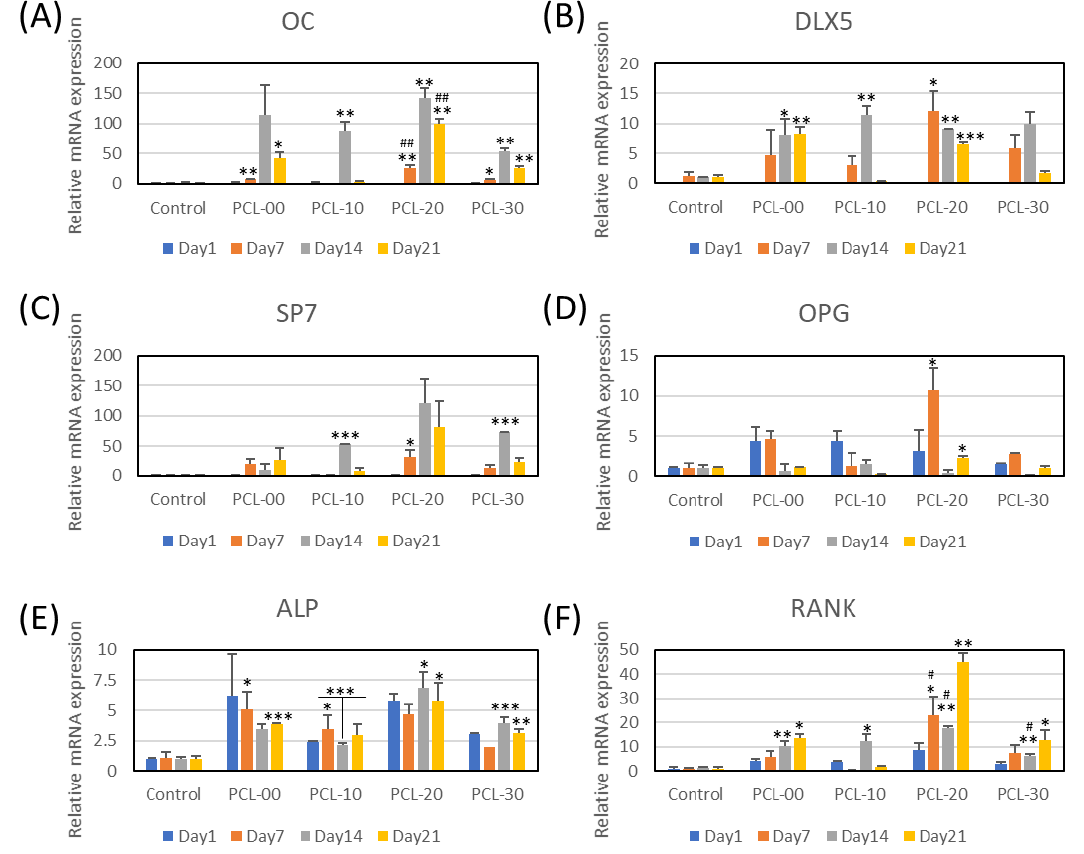
Figure 8. Gene expression of MG-63 cells when cultured in PCL/ β -TCP extraction medium for 1, 7, 14, and 21 days. Six different gene markers ( A ) OC, ( B ) DLX5, ( C ) SP7, ( D ) OPG, ( E ) ALP, and ( F ) RANK were analyzed. Significant differences are indicated with *, p < 0.05, **, p < 0.01, and ***, p < 0.001, when compared to control, while the # symbol indicates compared with PCL-00. Because mineralization is an essential process of bone healing, determining the scaf- folds’ ability to mineralize is necessary. To do this, MG-63 cells were cultured on PCL or PCL/ β -TCP scaffolds for 14 and 28 days (Figure 9). Mineralization ability increased corresponding to the amount of β -TCP added, indicating that PCL/ β -TCP composites are a potent bone healing material. PCL-20 and PCL-30 showed a significant increase in mineralization compared to PCL-00 on day 14 and day